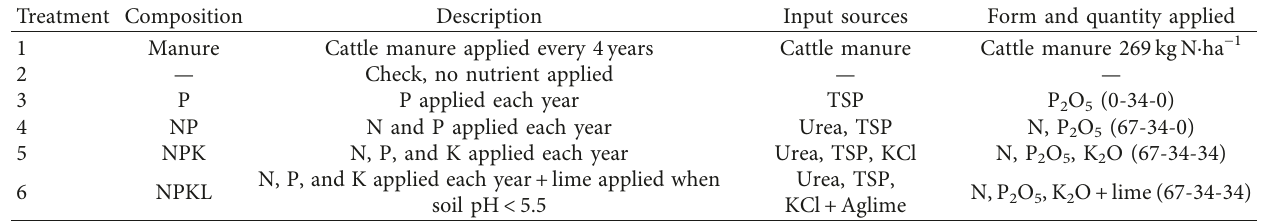
Table 1: Treatment structure, composition, and description for Magruder Plots located at Stillwater in Oklahoma, USA. Treatment Composition